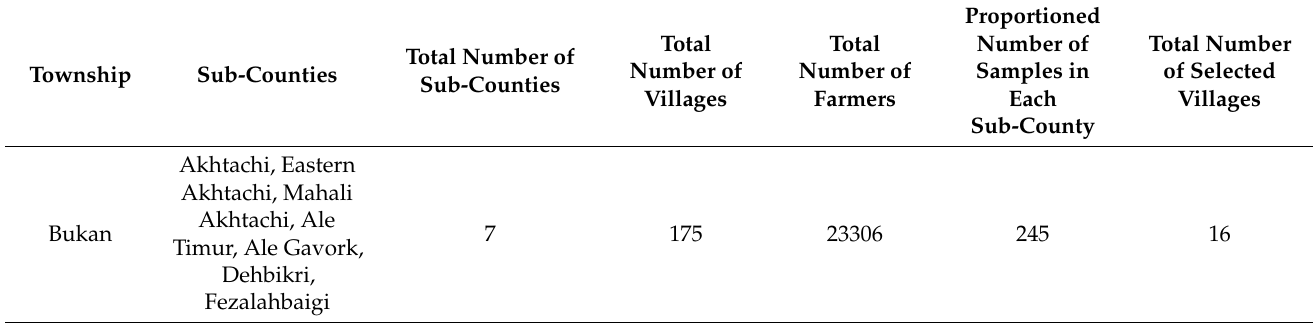
Table 2. The sample size according to stratified random sampling.